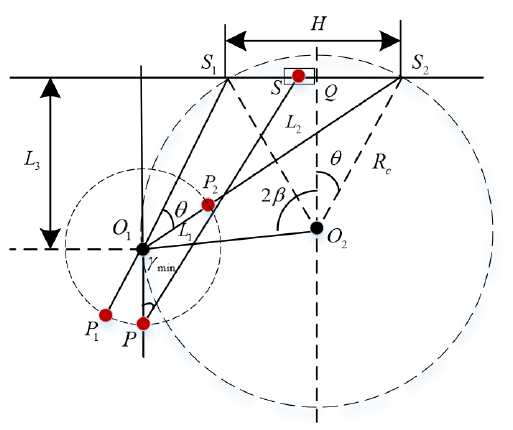
Figure 3. Dimensions optimization of slider crank mechanism.